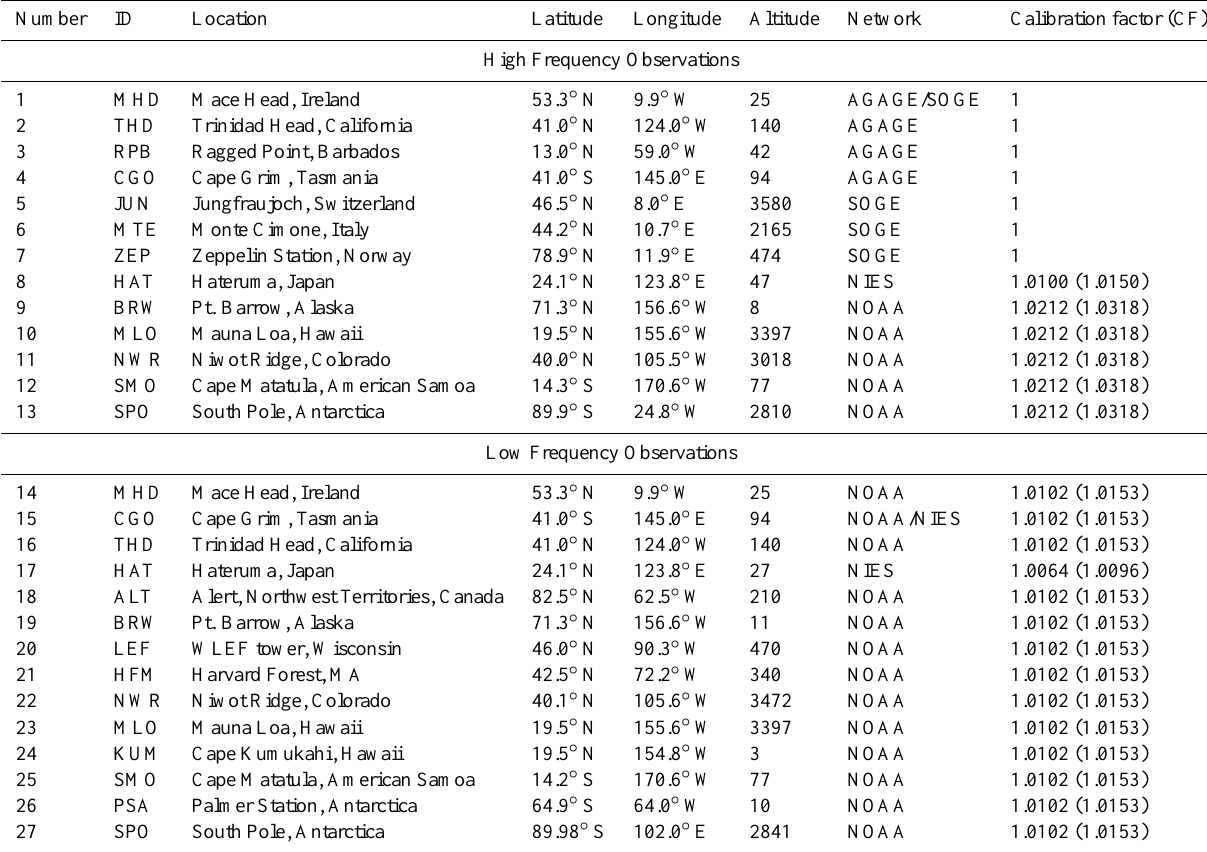
Table 1. Location of the CH 3 Cl measuring sites and their assumed calibration factors (CF) relative to the SIO-05 CH 3 Cl scale used by the AGAGE network. Data at each site were divided by the listed calibration factor in order to combine them under a common scale. Calibration factors in parentheses are used in a sensitivity exercise and are calculated by multiplying the interlaboratory differences (CF-1) by 1.5 (i.e., increasing the differences by